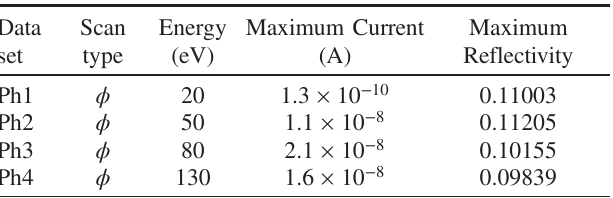
TABLE VII. Table of ϕ scan data sets, for aluminum sample #1. The angle θ 1 is fixed at 1.5°, and θ 2 is fixed at 2.6°